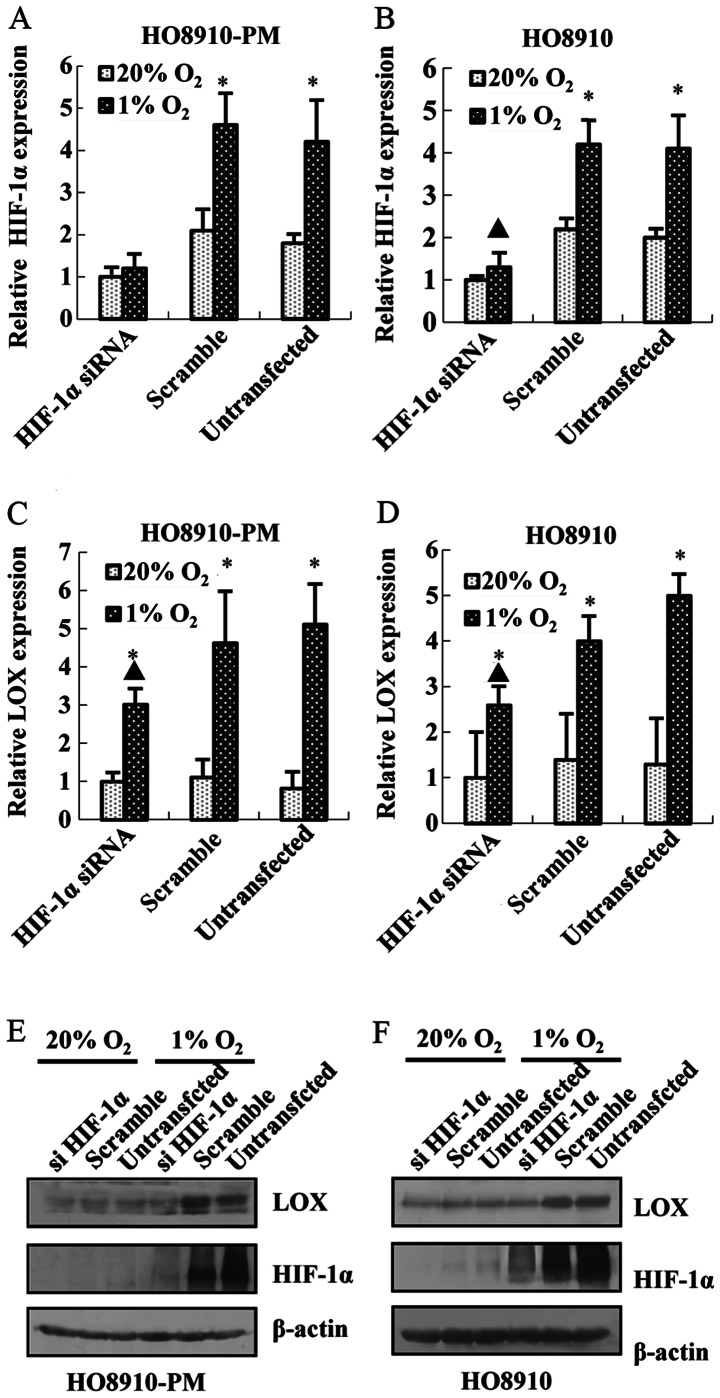
Knockdown of HIF-1α mRNA and protein expression by RNA interference in ovarian cancer cells. HO8910-PM and HO8910 cells were transfected with HIF-1α-siRNA or a scrambled siRNA, incubated for 24 h, and then exposed to normoxia (20% O2) or hypoxia (1% O2) for 24 h. Q-PCR analysis of HIF-1α mRNA expression in (A) HO8910-PM and (B) HO8910 cells. Q-PCR of LOX mRNA expression in (C) HO8910-PM and (D) HO8910 cells; GAPDH was used as a reference gene; ▴P<0.05 vs. control untransfected cells or non-specific siRNA-transfected cells under hypoxia, *P<0.05 vs. 20% O2 control cells; ANOVA (n=3 replicates per group). Western blots of HIF-1α and LOX protein expression in (E) HO8910-PM and (F) HO8910 cells. Knockdown of HIF-1α expression using a HIF-1α siRNA simultaneously reduced LOX protein expression in cells cultured under hypoxic conditions; this effect was more obvious in HO8910 cells than HO8910-PM cells. Each experiment was performed at least three times.